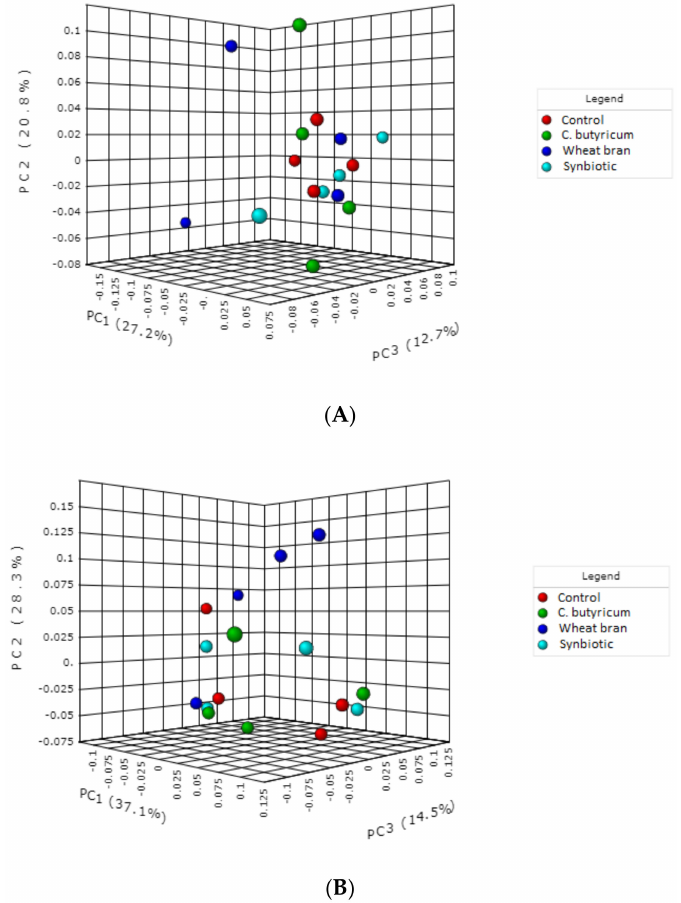
Figure 1. Beta diversity plots based on unweighted ( A ) and weighted ( B ) UniFrac from cecal bacteriota of chickens that received control, Clostridium butyricum supplemented, wheat bran supplemented and Clostridium butyricum + wheat bran (synbiotic) supplemented